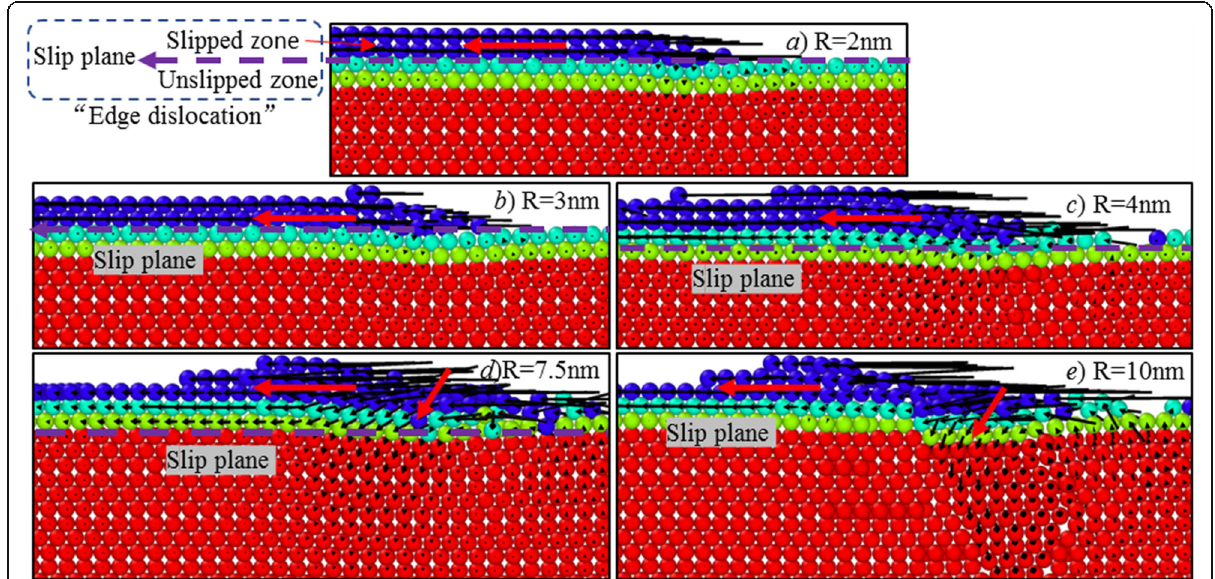
Fig. 10 Atomic displacement behaviour at various cutting-edge